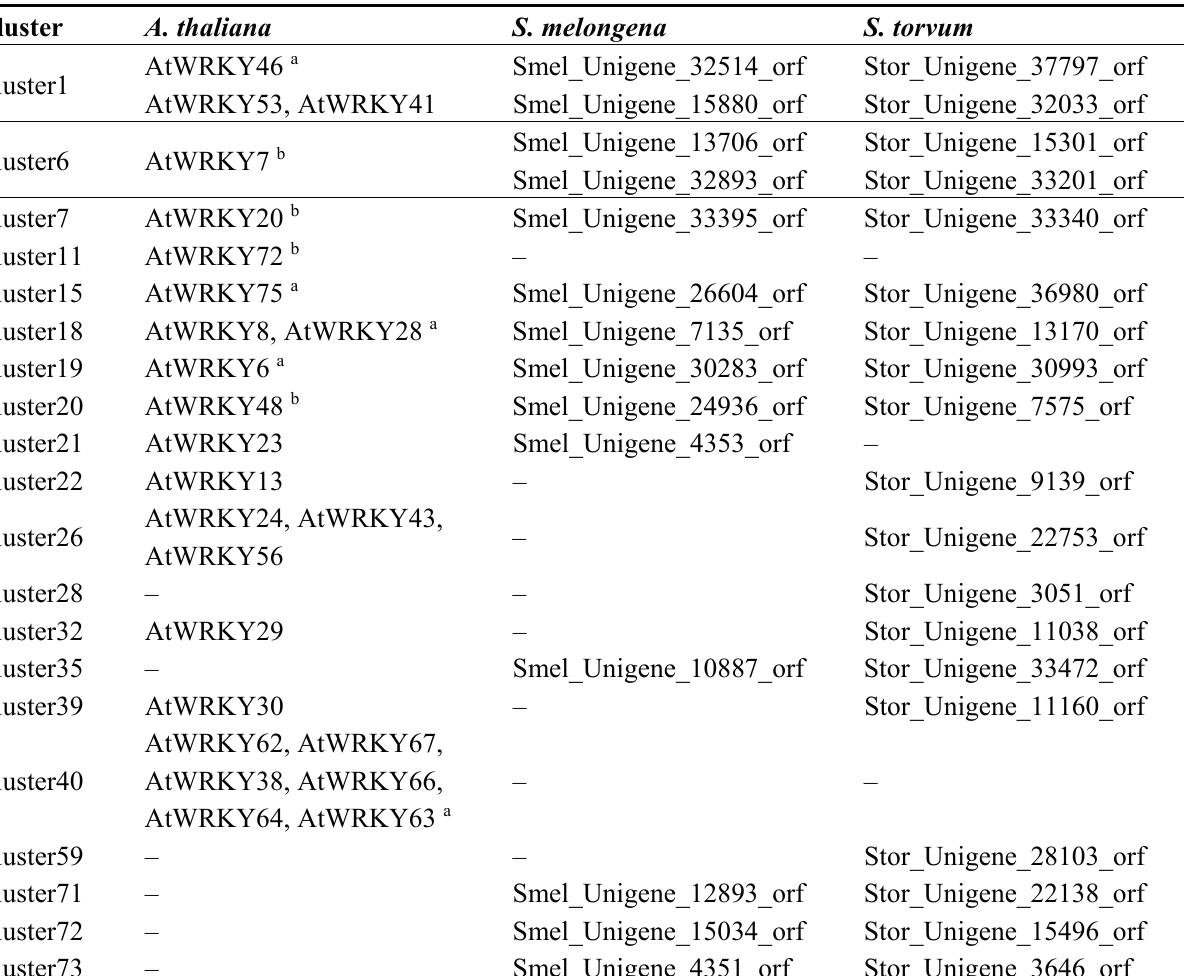
Table 4. Selected orthologous groups of AtWRKYs, SmelWRKYs and StorWRKYs. a Oxalic acid-responsive AtWRKY genes [53]; b jasmonate-responsive AtWRKY genes